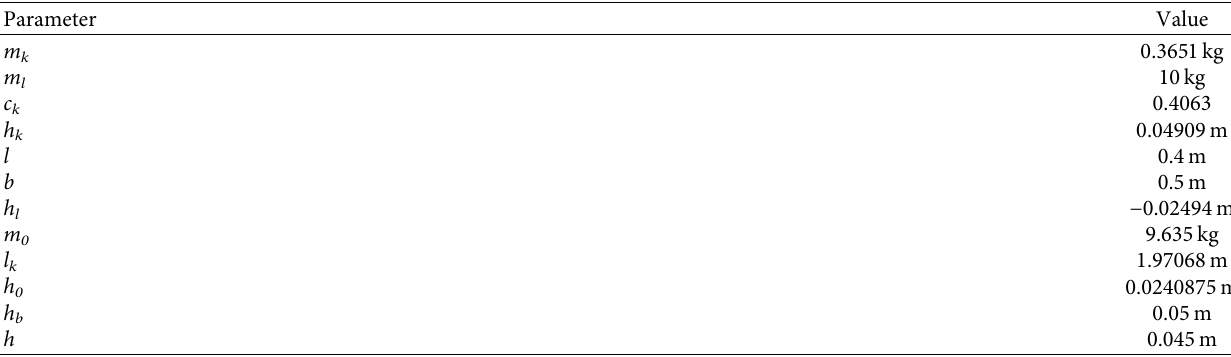
Table 6: Parameters of equivalent pendulum model.